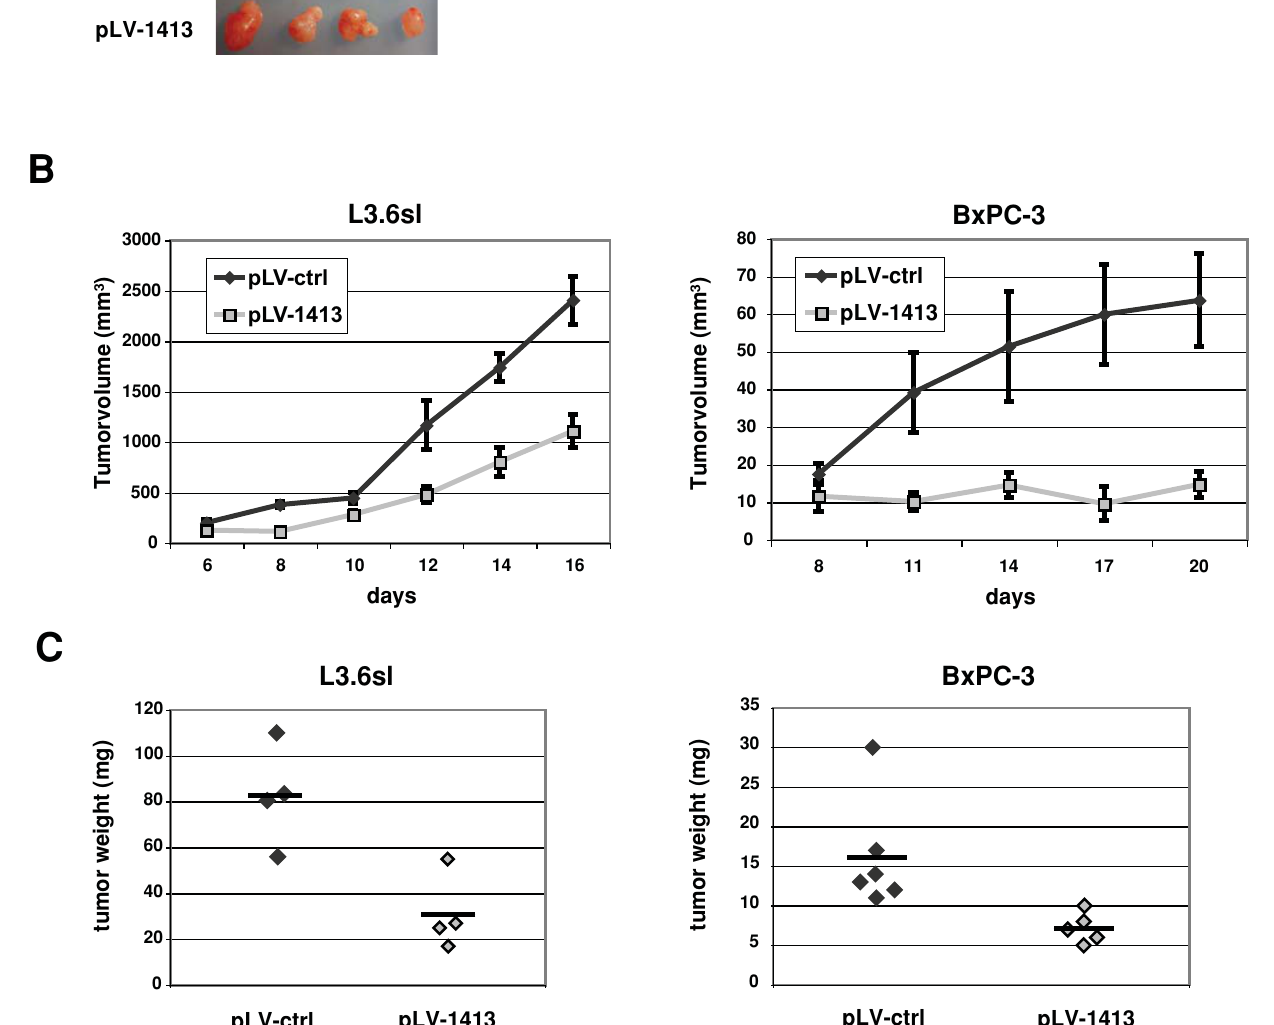
Figure 6. Tumorigenicity of L3.6sl and BxPC-3 cells silenced for Sulf-2. L3.6sl and BxPC-3 cells were transduced with either pLV-1413 or pLV-ctrl and subcutaneously injected into nude mice at 5 6 10 6 per site. A: L3.6sl derived tumors harvested from mice after 17 days of growth B: Tumor size was monitored over time and values represent the mean ( + /-SEM) of 4 mice for L3.6sl cells and 6 (pLV-ctrl) or 5 (pLV-1413) mice for BxPC-3 cells. C: Animals were sacrificed and tumor weight was examined. The difference in tumor weights between the two groups was significant for L3.6sl cells with a p-value of 0.01 and for BxPC-3 cells with a p-value of 0.029 (Student t-test).